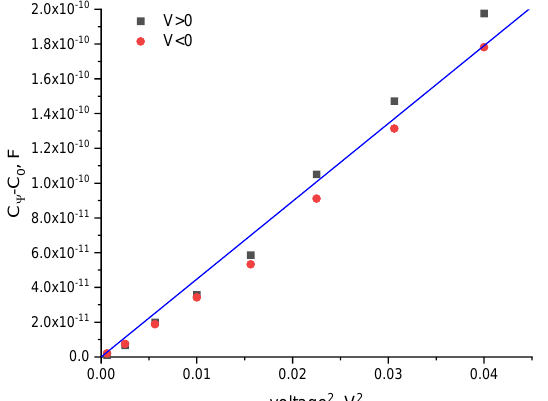
Figure 1. The voltage-dependent capacitance of a DOPC bilayer in hexadecane for both positive and negative applied voltages. The proportionality constant, α , is calculated by α = m /3 C 0 The proportionality constant can be used to determine Young’s modulus at a con- stant membrane volume, as described by White [31]: 𝐶 𝑚 𝐸 ⟘ = 𝛼𝑑 0 where 𝑑 0 is the thickness at 𝜓 = 0. Comparing the Alvarez constant volume method to our previous [22] approach results in approximately a threefold increase in 𝐸 ⟘ , as shown in Figure 2. The compression resulting from an applied potential is responsible for both a decrease in thickness and an increase in area due to the new membrane being formed from lipids present on the Plateau border surrounding the initial bilayer. These two changes occur simultaneously and have previously been implicitly assumed to occur under con- stant membrane volume. However, we find that membrane area increases in a dispropor- tionate manner when compared to the decrease in thickness, resulting in an increased volume with increasing field strength. This volume increase results in a lower calculated Young’s modulus following the method of Hianik ( Equation (2)) [23].